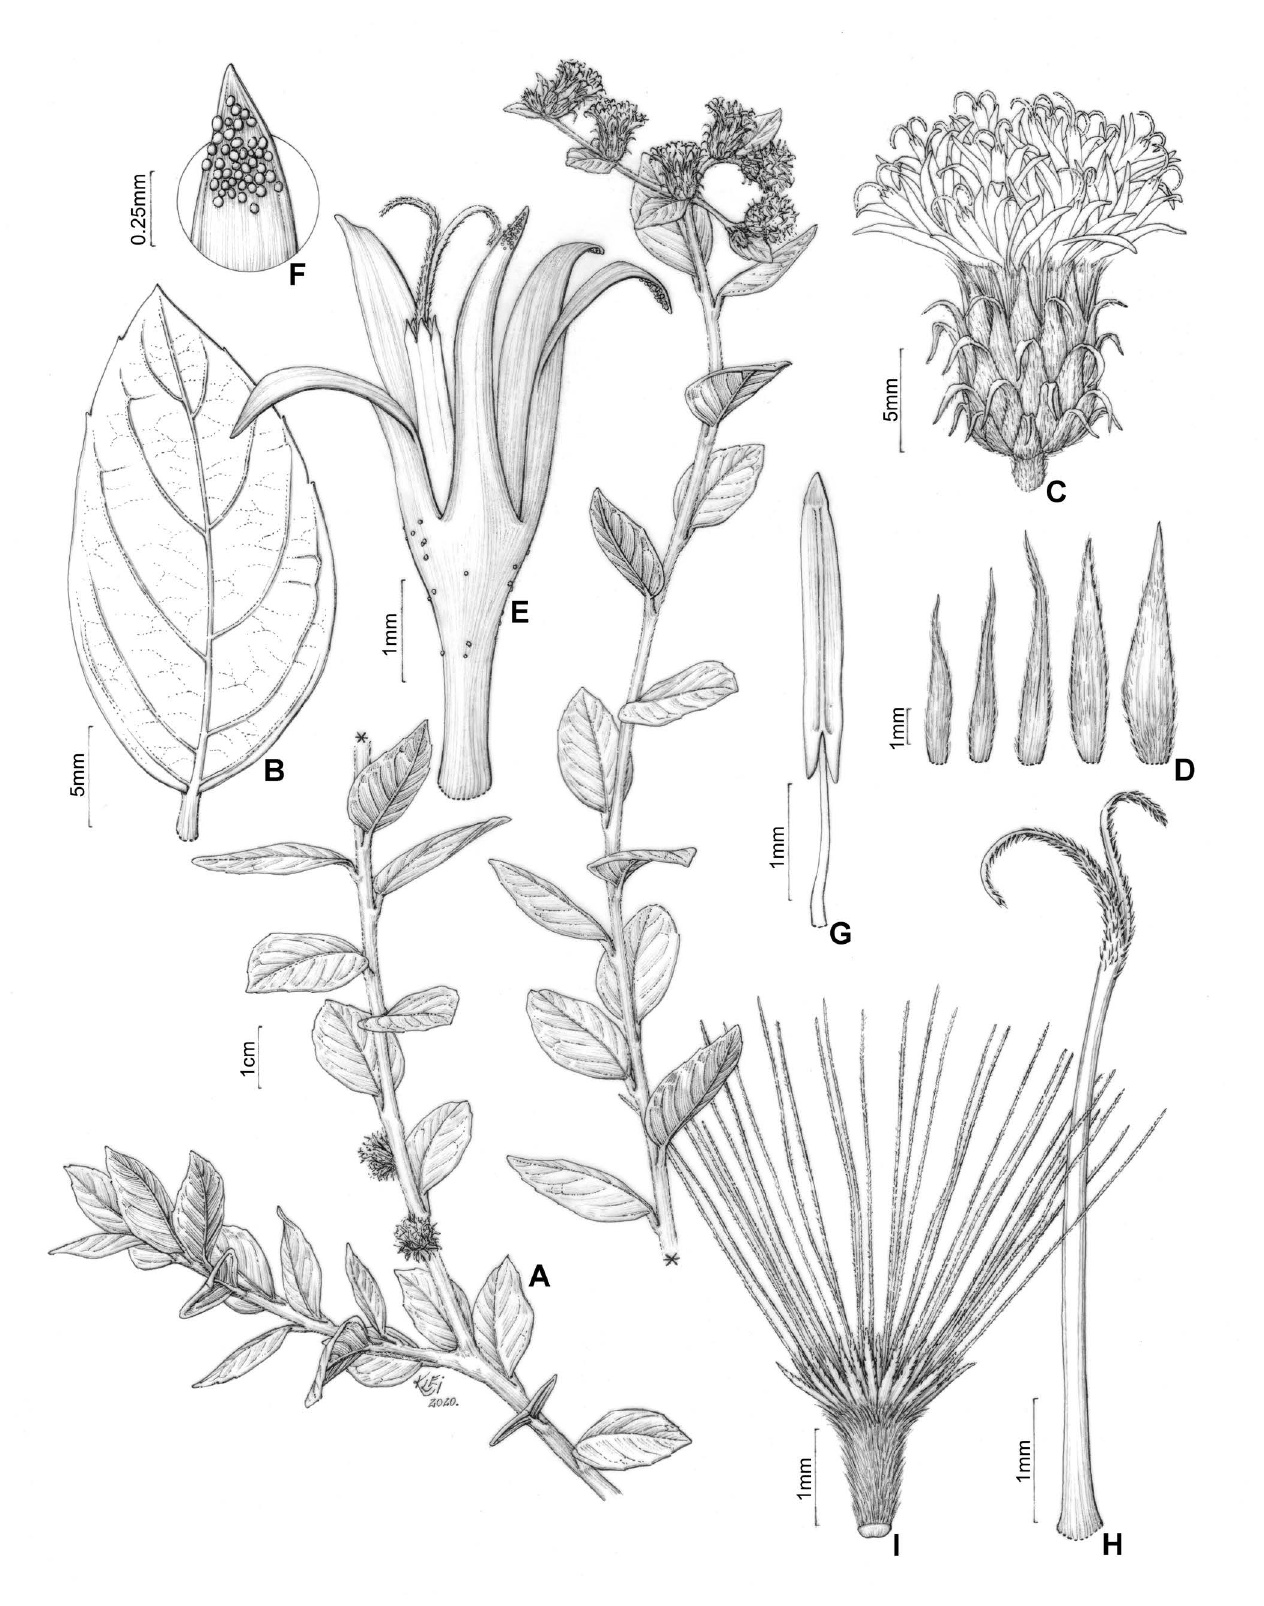
Figure 1 – Lepidaploa campirupestris Antar & Loeuille. A . Habit. B . Leaf, abaxial surface. C . Capitulum. D . Outer to inner involucral bracts. E . Corolla, stamens, and style. F . Corolla lobe apex. G . Stamen. H . Style. I . Cypsela with pappus. A–I from Loeuille et al. 891 (SPF). Illustration by Klei